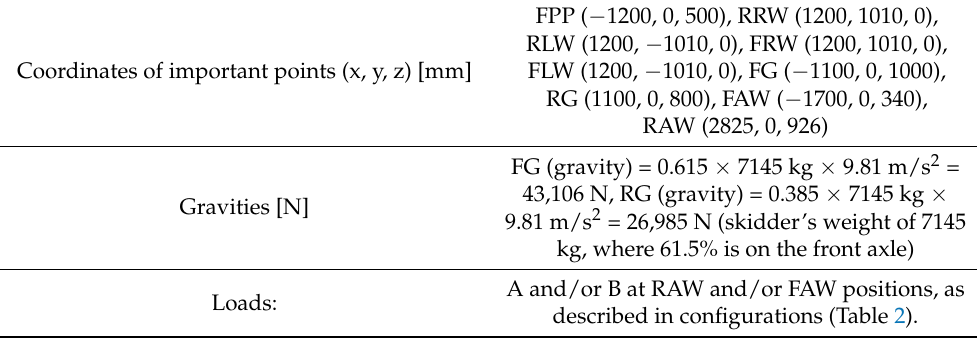
Table 1. Basic parameters of alternative skidder model (as shown on Figure 2).